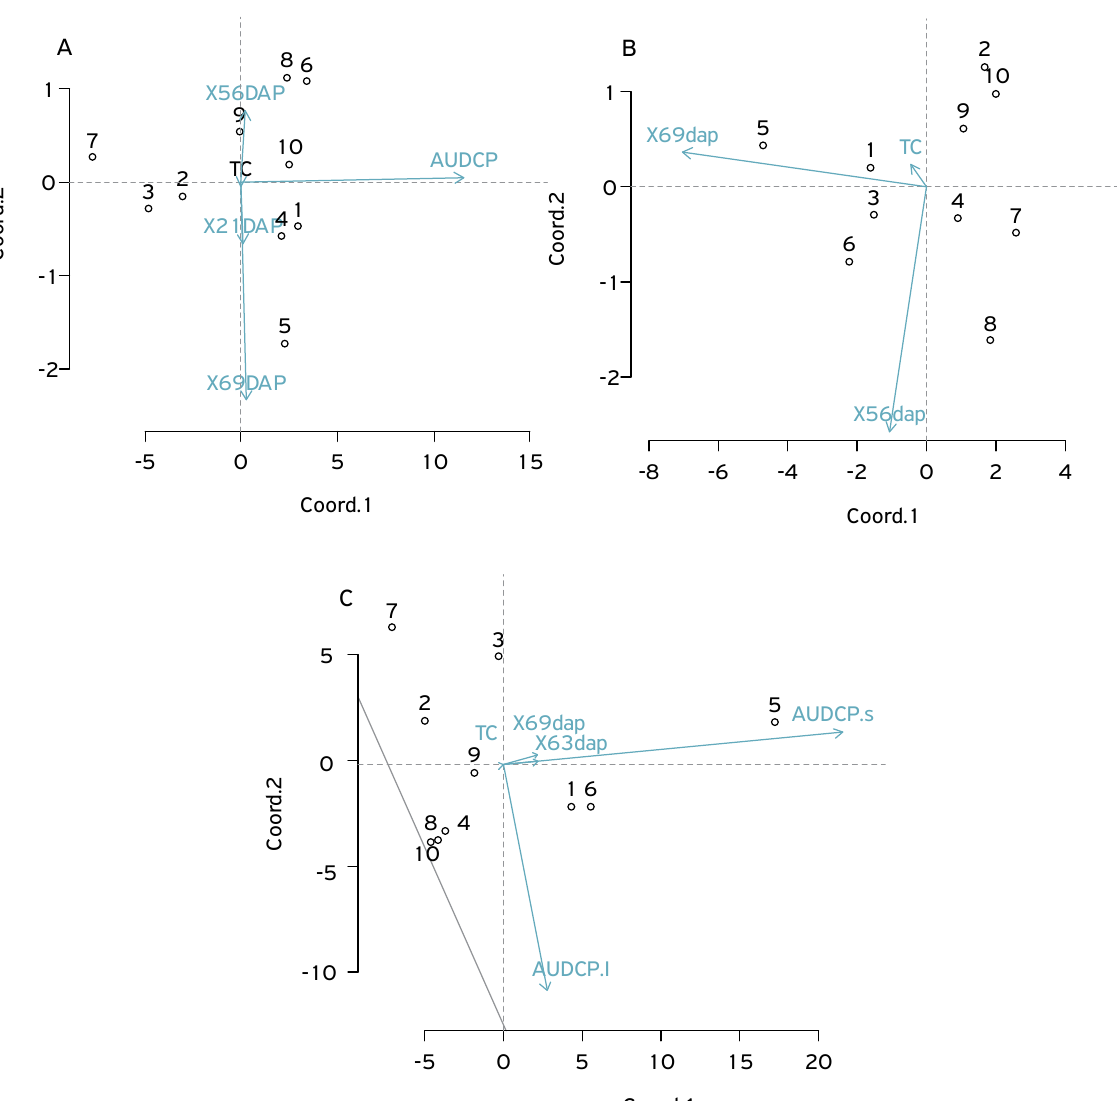
Figure 2. Main component of sanitary variables evaluated on common bean cultivars. (A) Incidence (%) on different DAP; AUDCP.I: area under the disease curve progress; GR: growth rate; (B) Severity (%) by DAP; AUDCP.S: area under the disease curve progress by severity sanitary; GR: growth rate by plant disease; (C) Interaction between dependent variables for cultivars ranking. 1. BRS Estilo © , 2. BRS Pérola © , 3. IPR Tangará © , 4. IPR Tuiuiú © , 5. IPR Uirapuru © , 6. IAC Milênio © , 7. Imperador © , 8. IAC F3 R2 © , 9. IAC OTG © and 10. IPR Campos Gerais ©